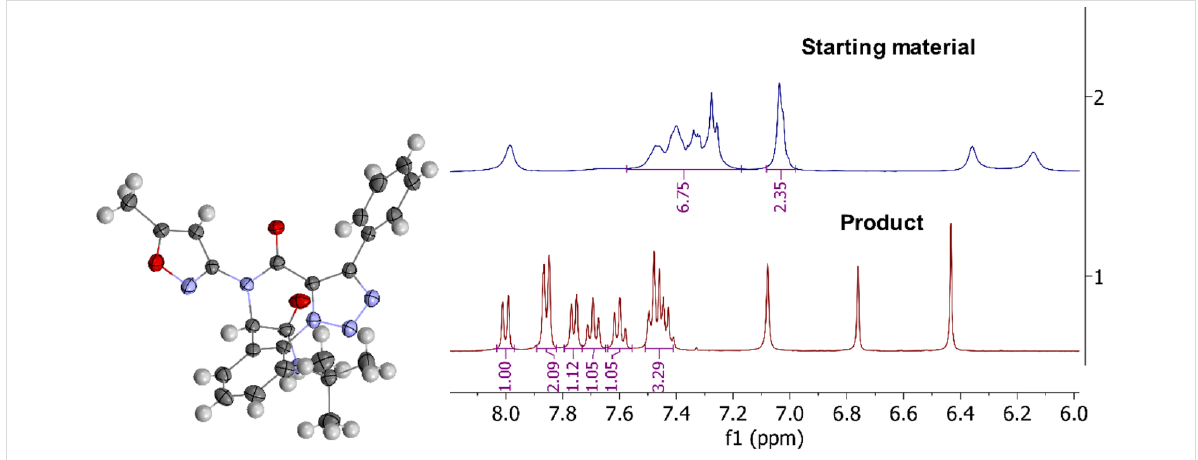
Figure 5: Molecular structure of compound 7aaa (X-ray analysis) and comparison of 1 H NMR spectra of compounds 6aaa and 7aaa .